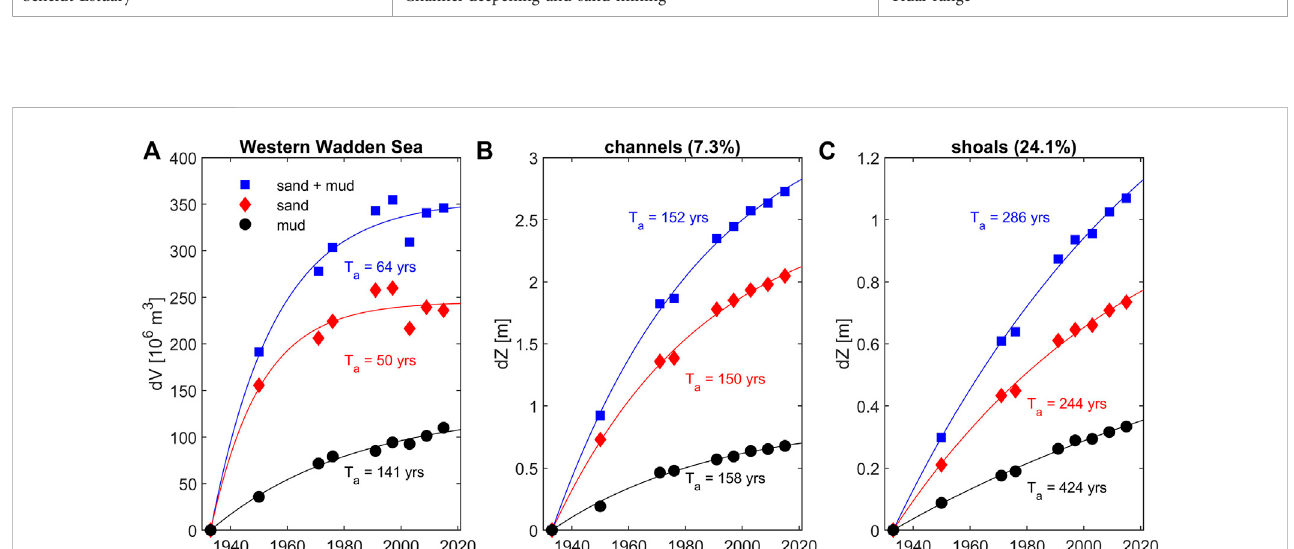
FIGURE 8 Total volume changes (A) , in 10 6 m 3 ) of sand and mud in the Western Dutch Wadden Sea since 1933 (closure of the South Sea) from Colina Alonso et al. (2021) and accretion rates (in m) in rapidly in fi lling dead-end channels (B) and accreting fringing shoals (C) . The size of the channel (shoal) area is 111,10 6 m 2 (367,10 6 m 2 ) corresponding to a volume of 304,10 6 m 3 (392,10 6 m 3 ) – see Figure 2 for locations and Colina et al. (2021 for detailed historical changes). The adaption timescale Ta is computed using Eq. 1 (with colouring denoting the sediment type Ta is computed for). The channel and shoal percentage of panel (B) and (C) provide the spatial coverage relative to the total (A) .